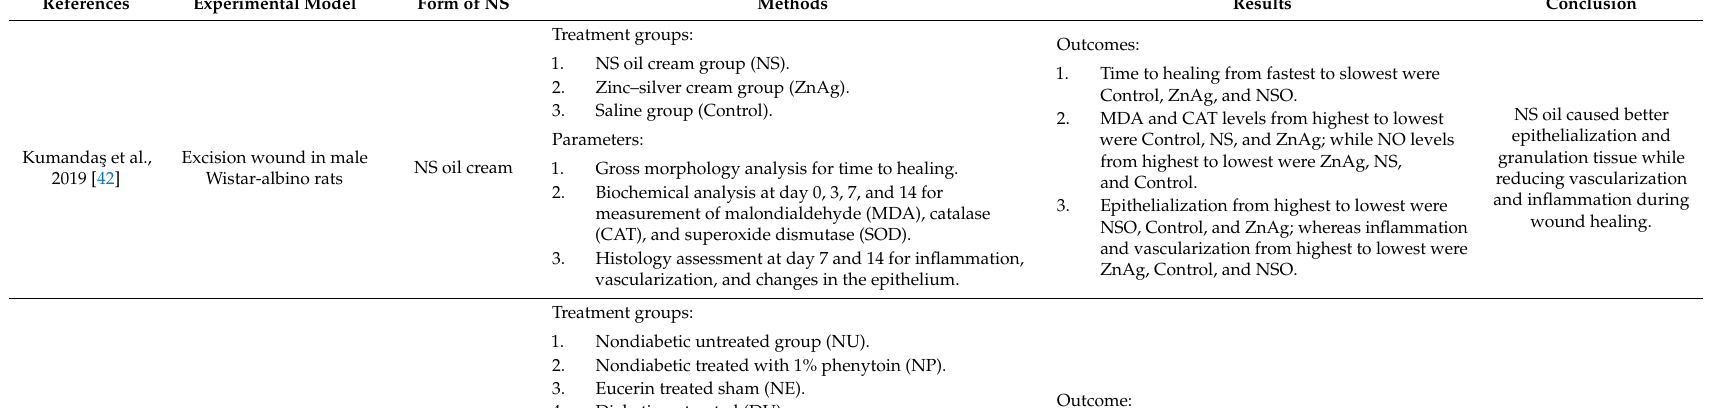
Table 1. Summary of Nigella sativa (NS)